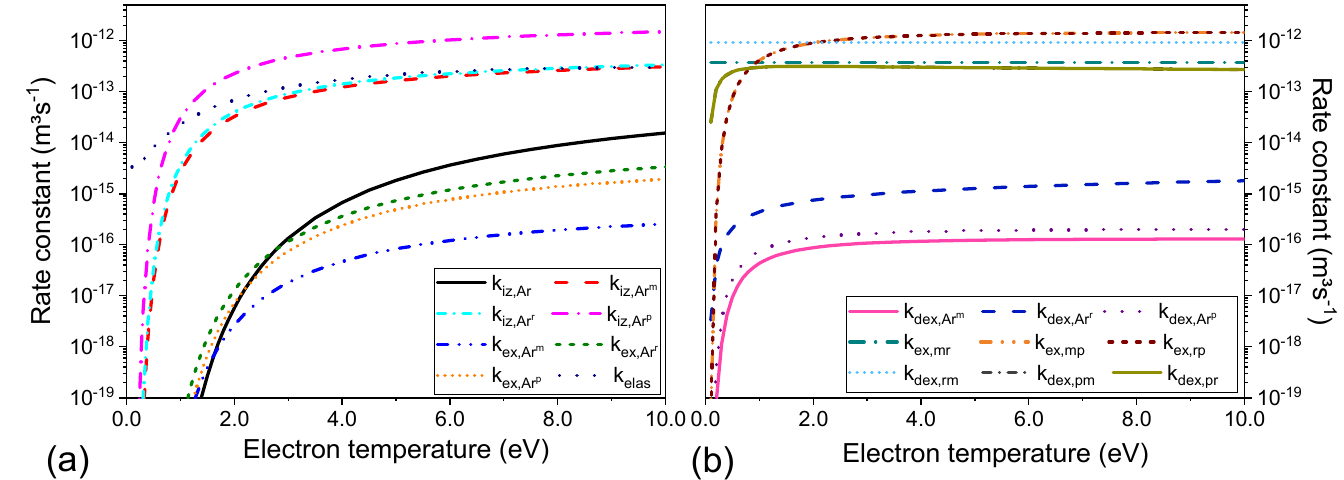
Figure 2. Rate constants for elastic, excitations, deexcitations, and super-elastic collision, reactions 1–8 ( a ) and 9-17 ( b ) of Table 1.